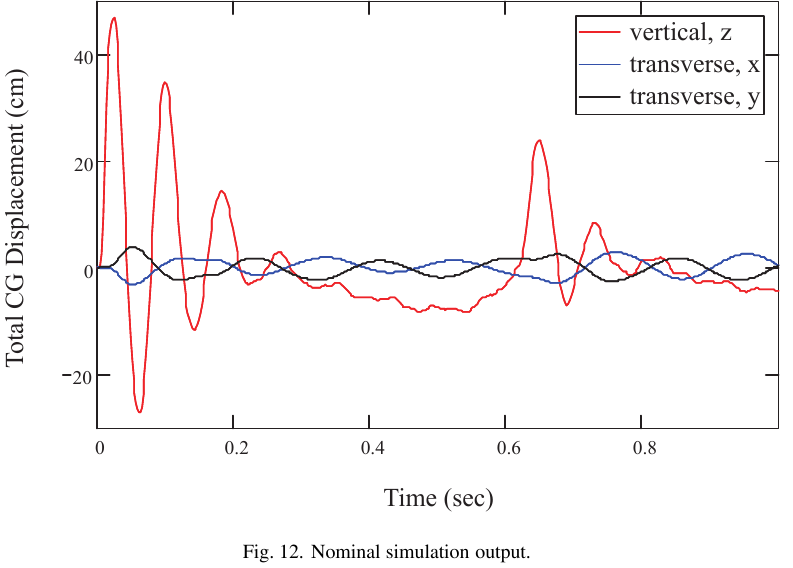
Fig. 12. Nominal simulation output.